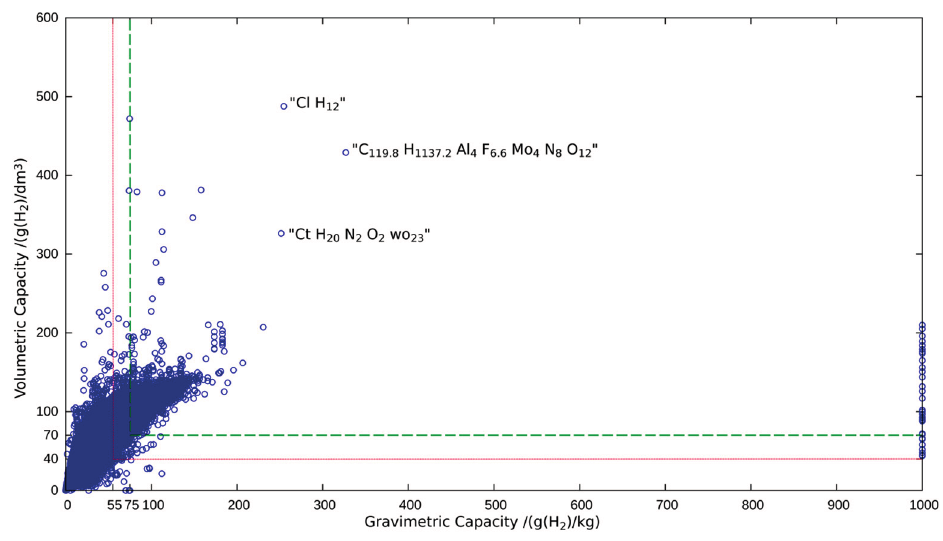
Figure 2. Plot of all hydrogen containing cif entries in the Crystallography Open Database (COD) with respect to their gravimetric and volumetric hydrogen capacity (blue open circles). The dotted line (red) corresponds to the 2020 US Department of Energy (DoE) targets, while the green dashed line corresponds to the ultimate DoE targets. Some prominent outliers are denoted with their sum formula as taken from the respective cif files